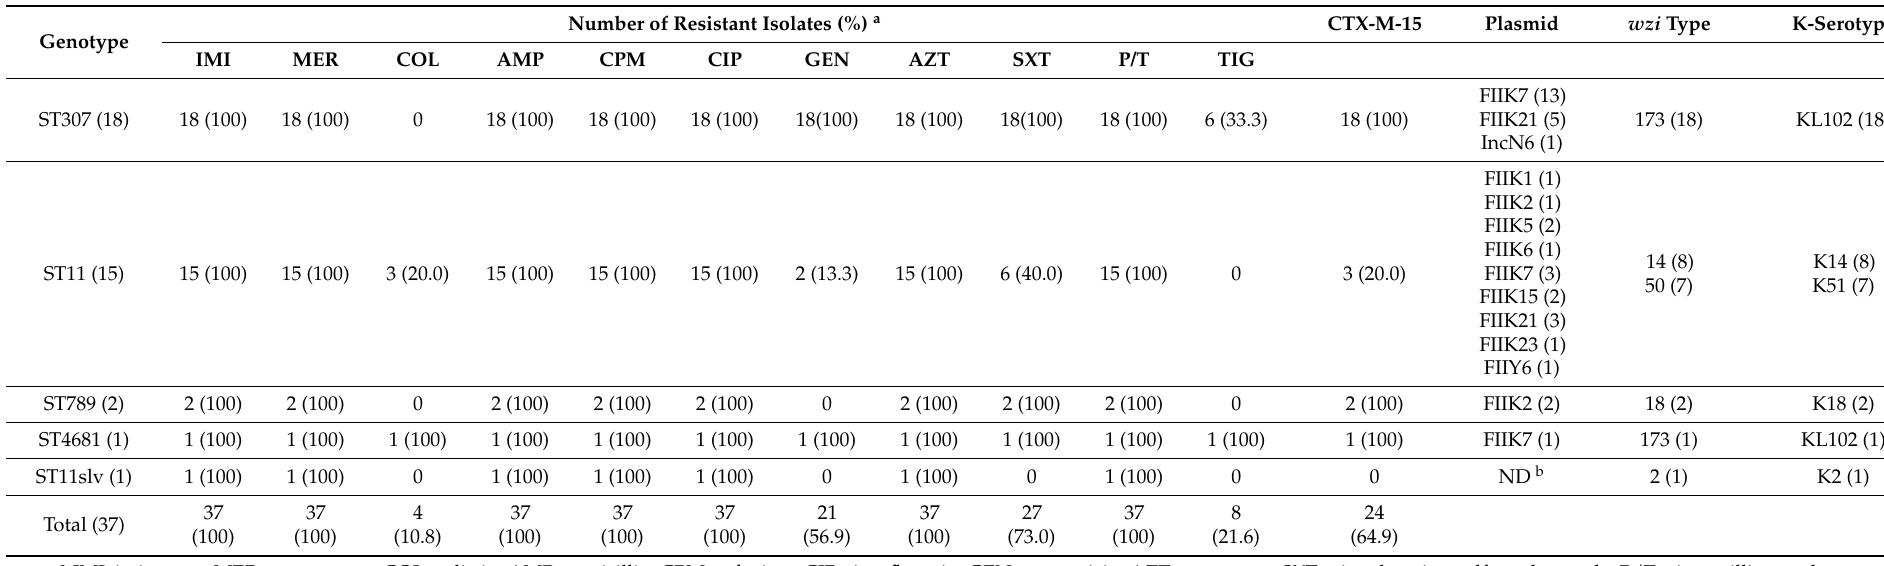
Table 1. Genotype, antimicrobial resistance, plasmid incompatibility group, wzi type, and K-serotype of carbapenemase-producing K. pneumoniae isolates investigated in this study.